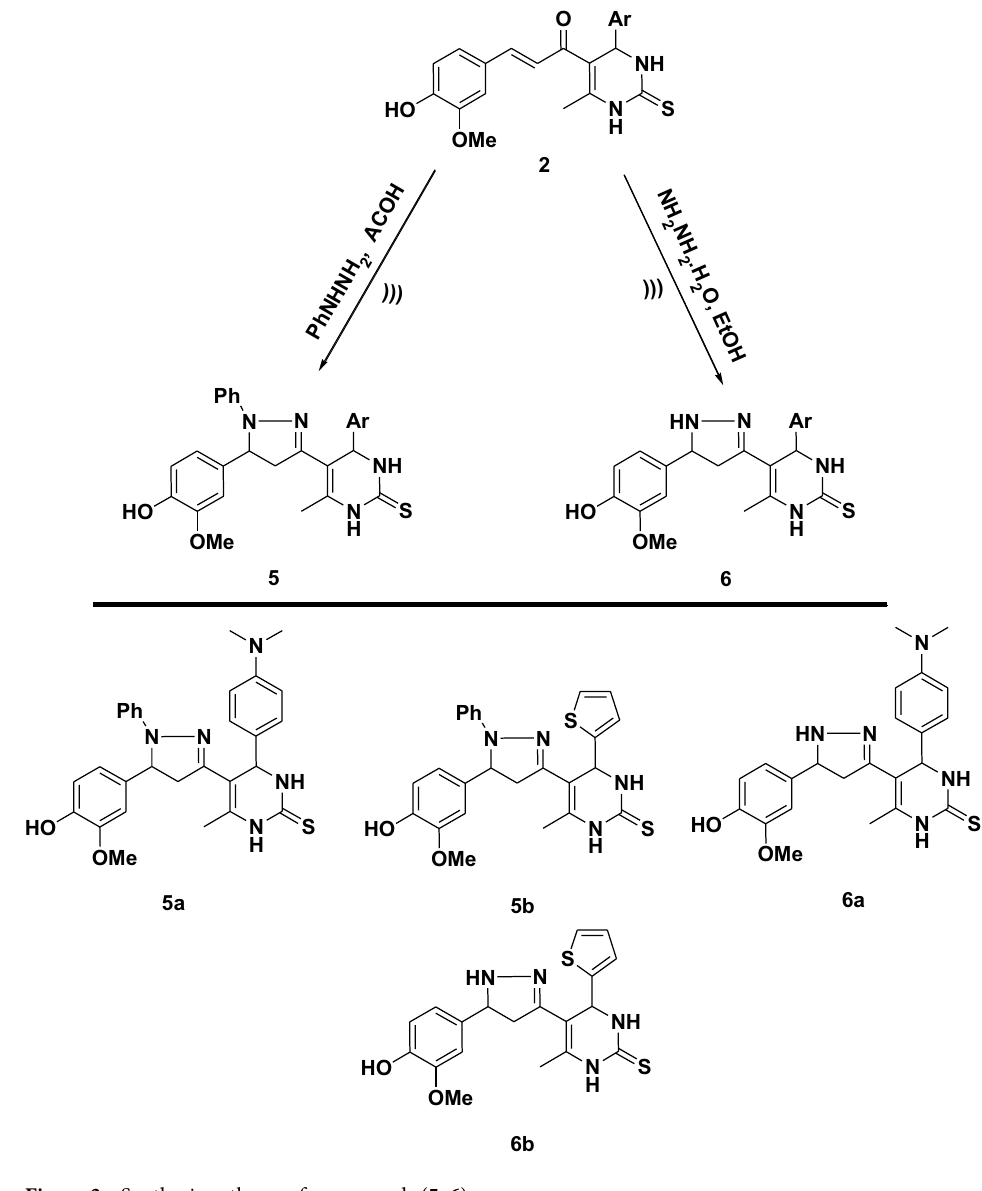
Figure 3. Synthesis pathway of compounds ( 5 , 6 ).